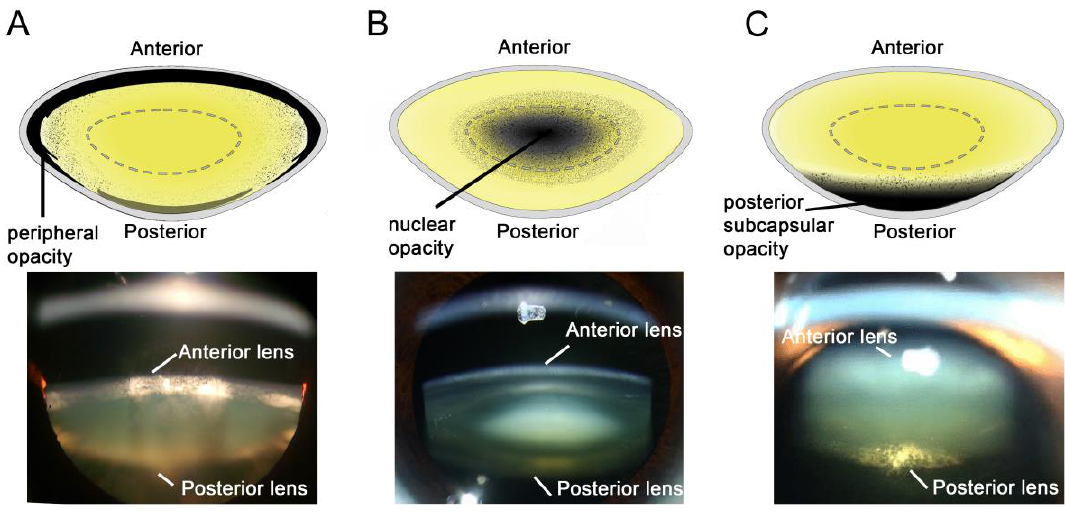
Figure 1. Location of cataract subtypes. Schematic diagrams and scheimpflug slit-lamp photographic images showing the three main types of cataract: ( A ) cortical, ( B ) nuclear, and ( C ) posterior subcapsular (PSC). Source: ( A ) From Uspal NG, Schapiro ES (February 2011). Cataracts as the initial manifestation of type 1 diabetes mellitus. Pediatric Emergency Care. 27 (2): 132–4. Attribution-ShareAlike